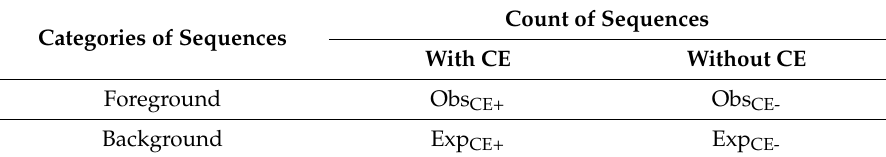
Table 1. 2 × 2 contingency tables for the calculation of the significance of CE. We applied this table for computation of the CE significance regardless motifs conservation (this is in respect to all CEs of the scatterplot in Figure 1B) and CE significances for asymmetric CE with more conserved one or another motif (these cases are in respect to two triangles of the same scatterplot).